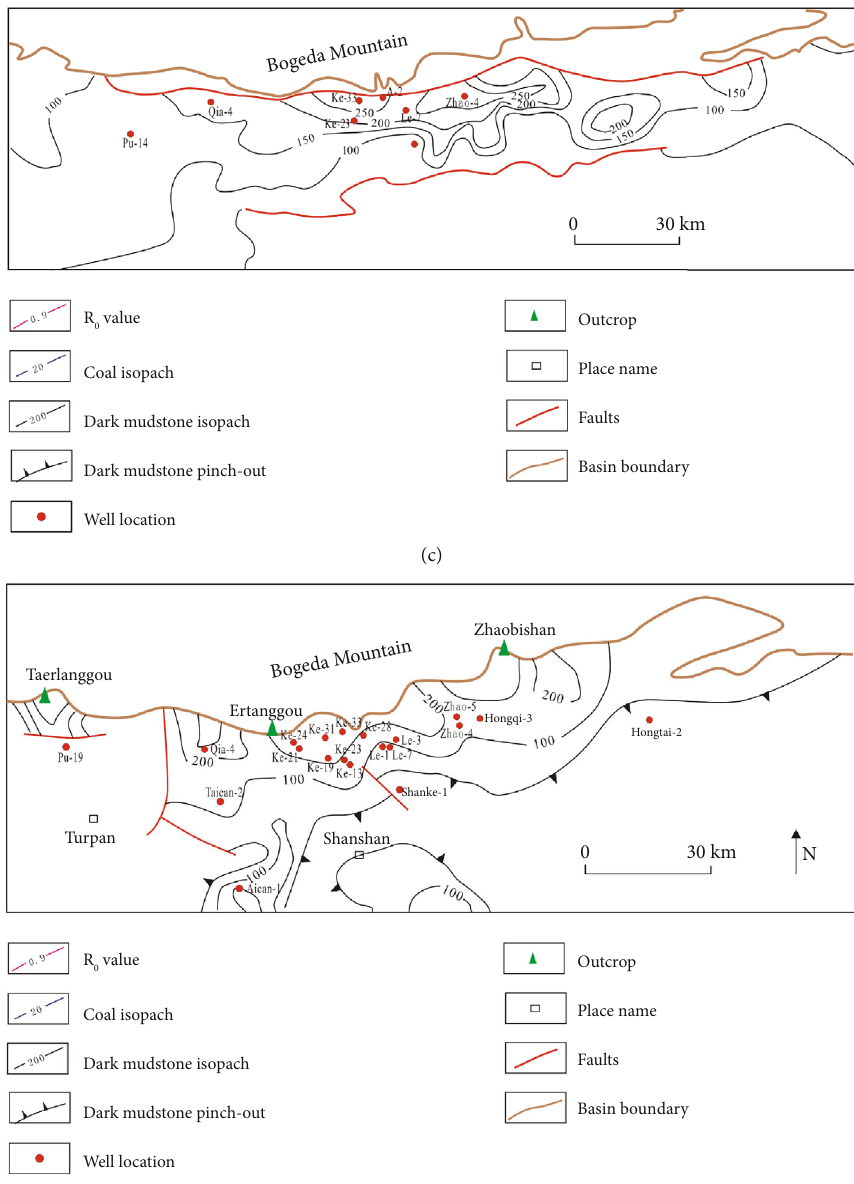
fi ed according to literature [14]). (a) Coal Figure 2: Thickness and R o isopach of the typical source rocks of Turpan-Hami Basin (modi thickness isopach of the Xishanyao Formation and R o value of the Xishanyao Formation bottom. (b) Coal thickness isopach of the Badaowan Formation and R o value of the Badaowan Formation bottom. (c) Dark mudstone thickness isopach of the Badaowan Formation. (d) Dark mudstone thickness isopach of the Taodonggou Group and locations of oil and gas